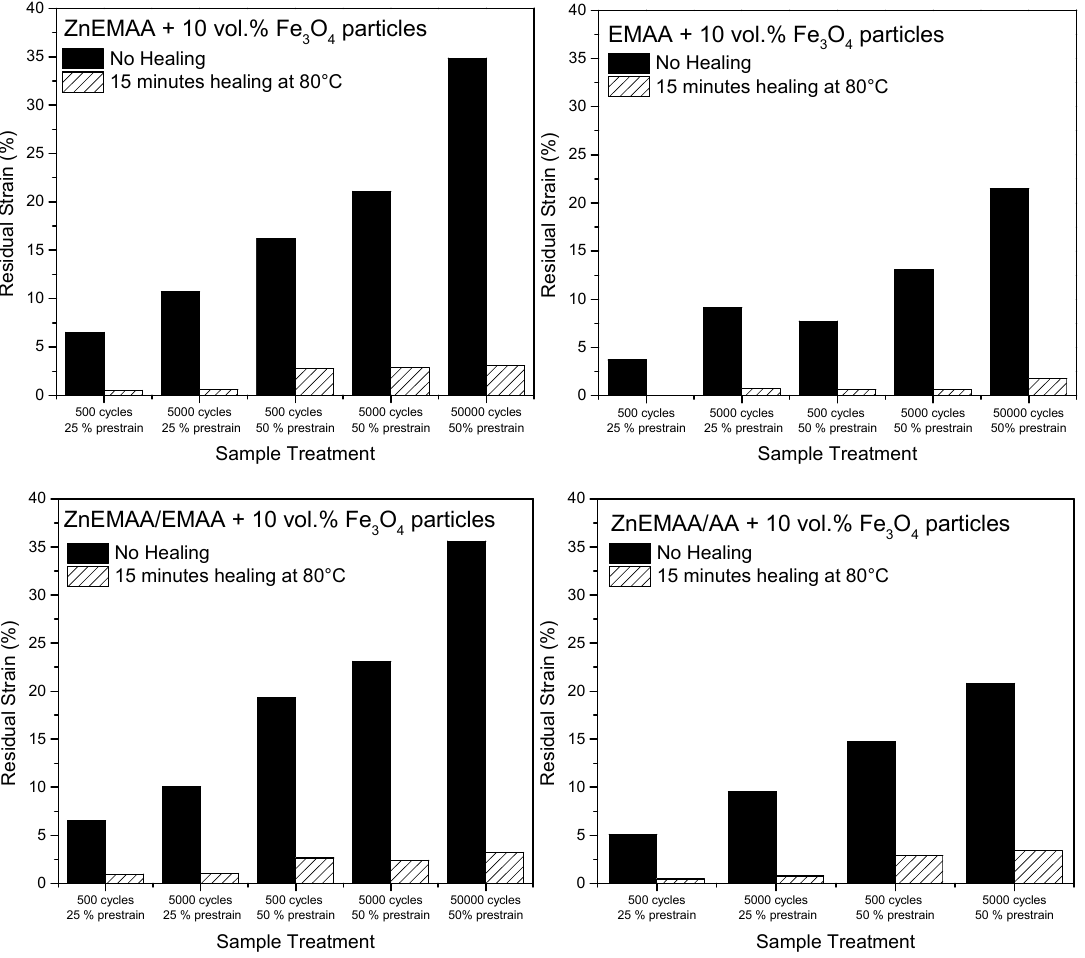
Figure 5. Strain restoration after fatigue treatments of Zn-EMAA, EMAA, Zn-EMAA/EMAA and Zn-EMAA/AA composites. Results are shown for different treatments based on the amount of strain cycles and the prestrain that was applied to the composites.